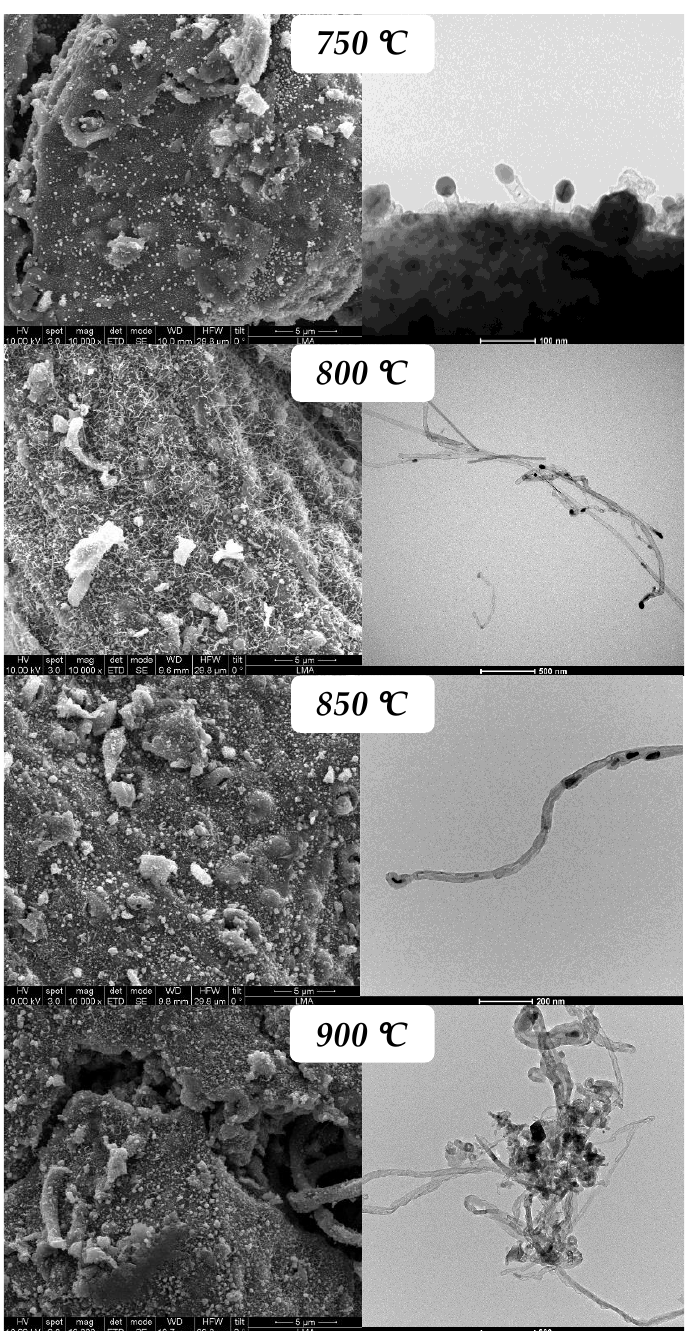
Figure 6. SEM and TEM images of the carbonaceous nanomaterials grown at different reaction temperatures for Co – Cu/ArDC. Feed composition (%):CH 4 /H 2 /N 2 .: 28.6/14.3/57.1.